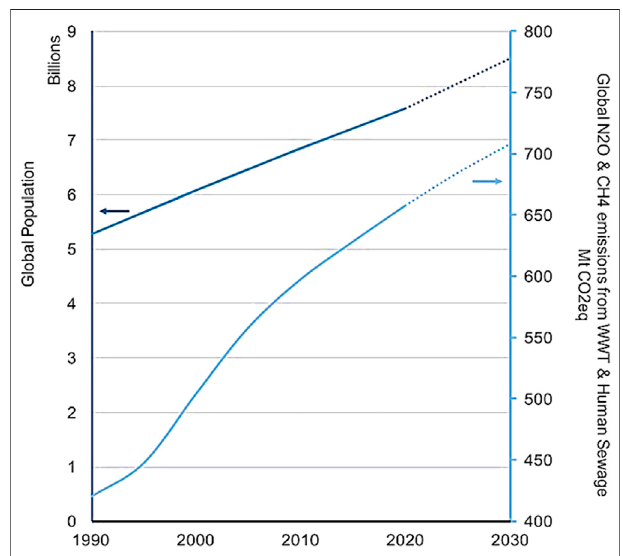
FIGURE 3 | The projected global population along with the total nitrous oxide and methane emissionsfrom human sewage and domestic wastewater in Mt CO 2 eq from 1990 – 2030 (data from USEPA, 2012; Isaksson et al., 2020).